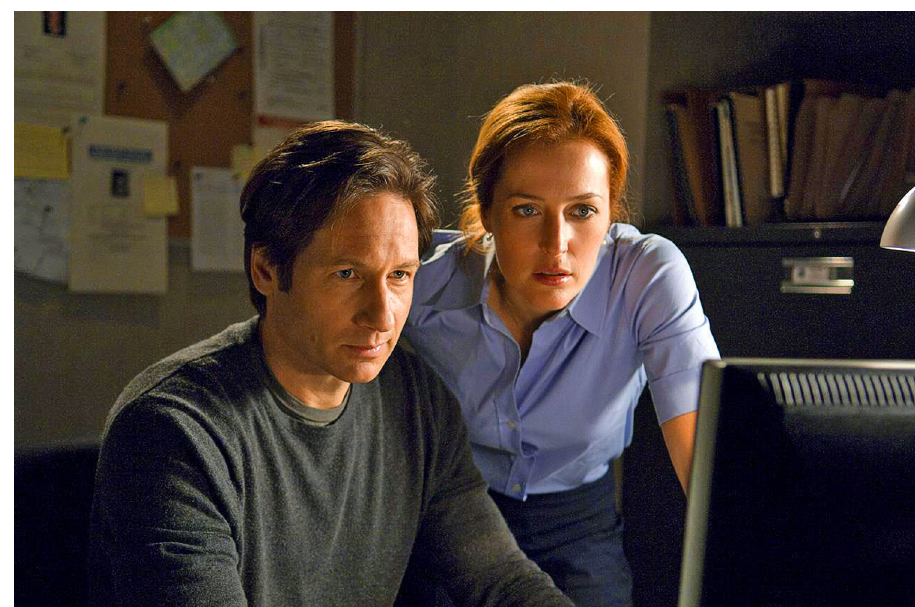
Figure 1: Image used for the announcement of The X - Files ’ return.